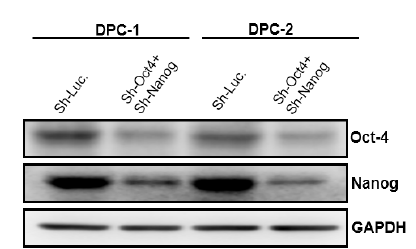
Figure 3. Depletion of Oct4 / Nanog impairs proliferation rate and osteogenic properties in STRO-1 + CD146 + DPSCs ( A ) Single cell suspensions of STRO-1 + CD146 + DPSCs